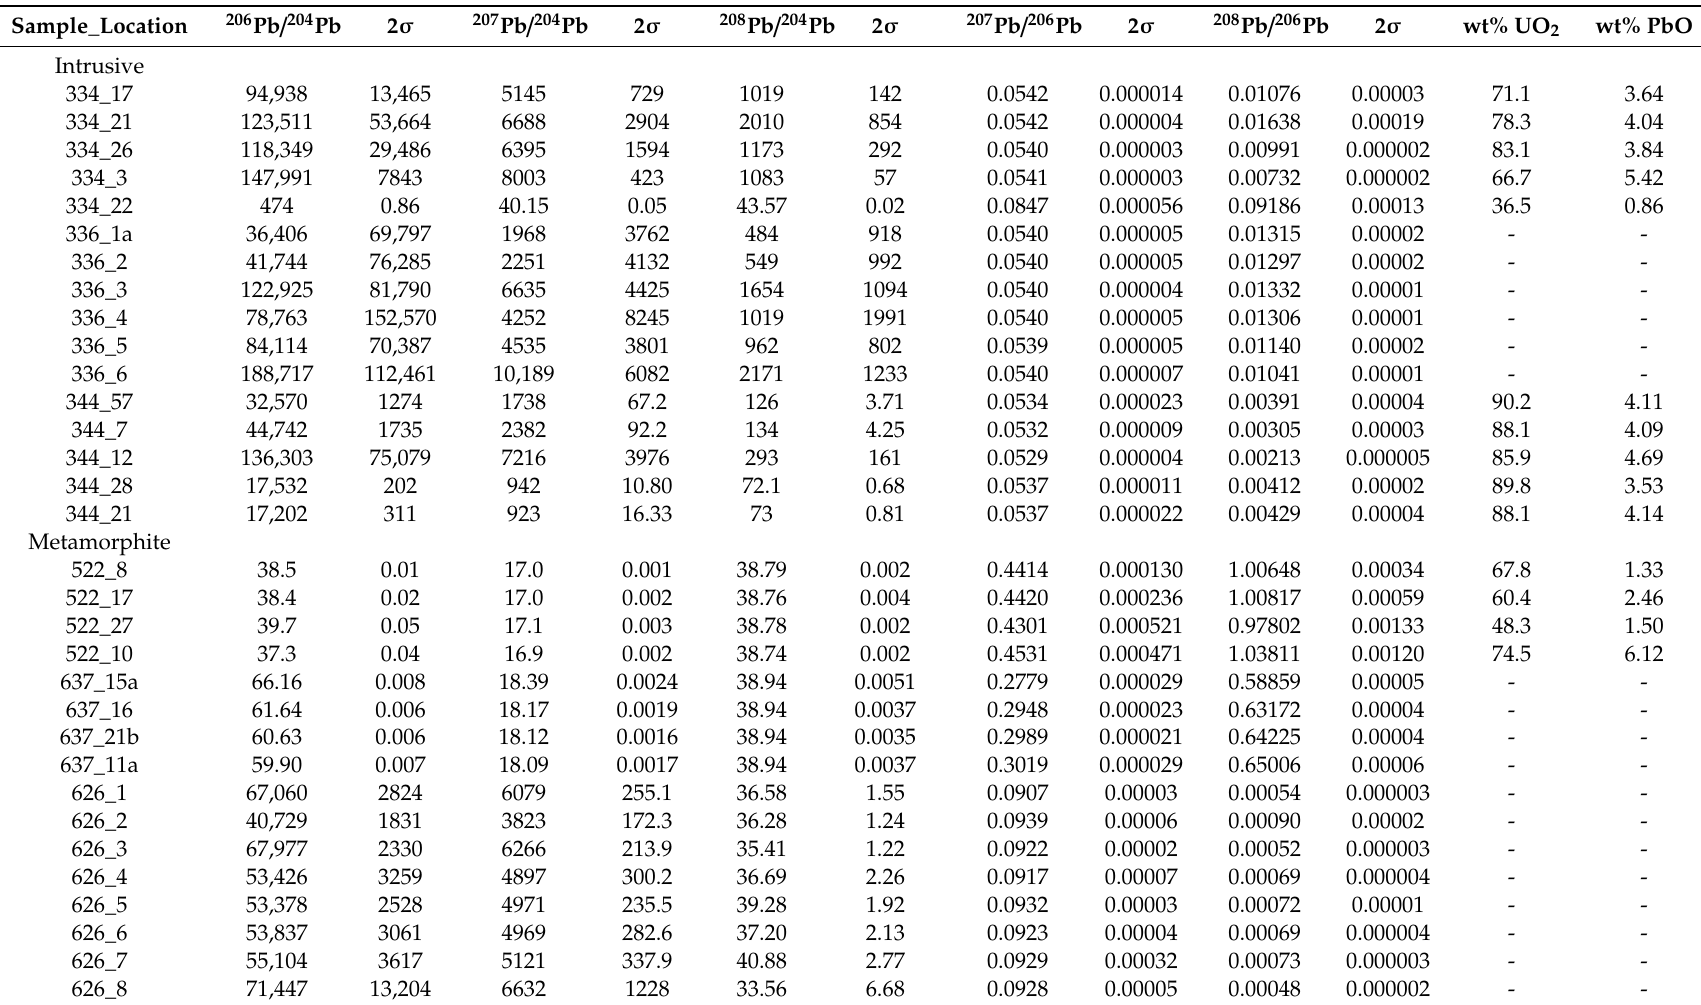
Table 4. Isotopic Pb ratios obtained by laser ablation (LA) MC-ICP-MS and wt% UO 2 and PbO determined by electron microprobe